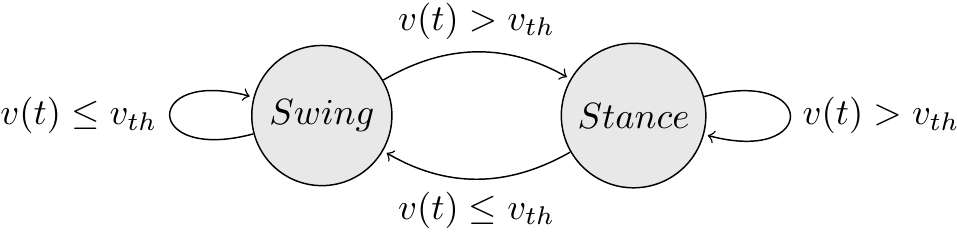
Figure 3. State diagram denoting the conditions required to determine the current gait state. Transi- tions between swing and stance phases occur by comparing the selected measure u ( t ) with a threshold value u th